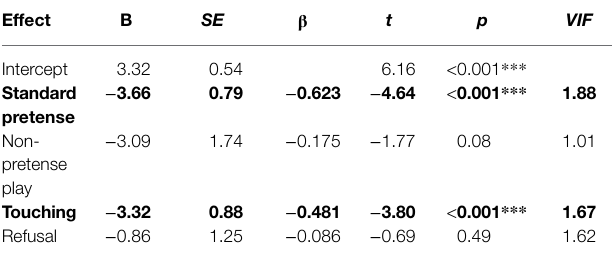
TABLE 3 | Coefficients of “standard pretense,” “non-pretense play,” “touching,” and “refusal” in multiple regression analyses and the variance inflation factor (VIF).